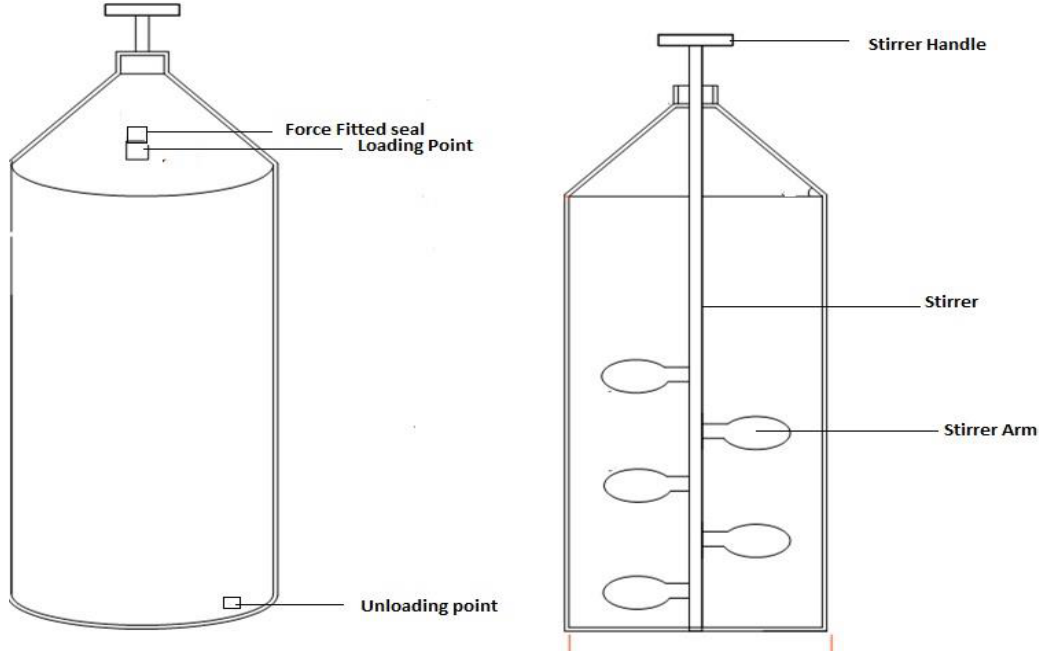
Figure 1. Schematic view of the locally developed aluminum storage silo.